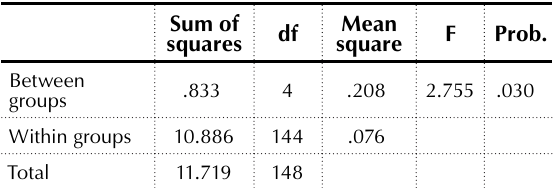
Table 4. The results of the ANOVA test Sum of